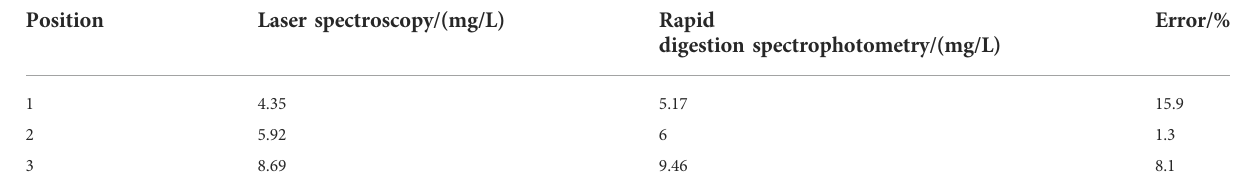
TABLE 1 COD measurement result of natural water samples. Position Laser spectroscopy/(mg/L) Rapid